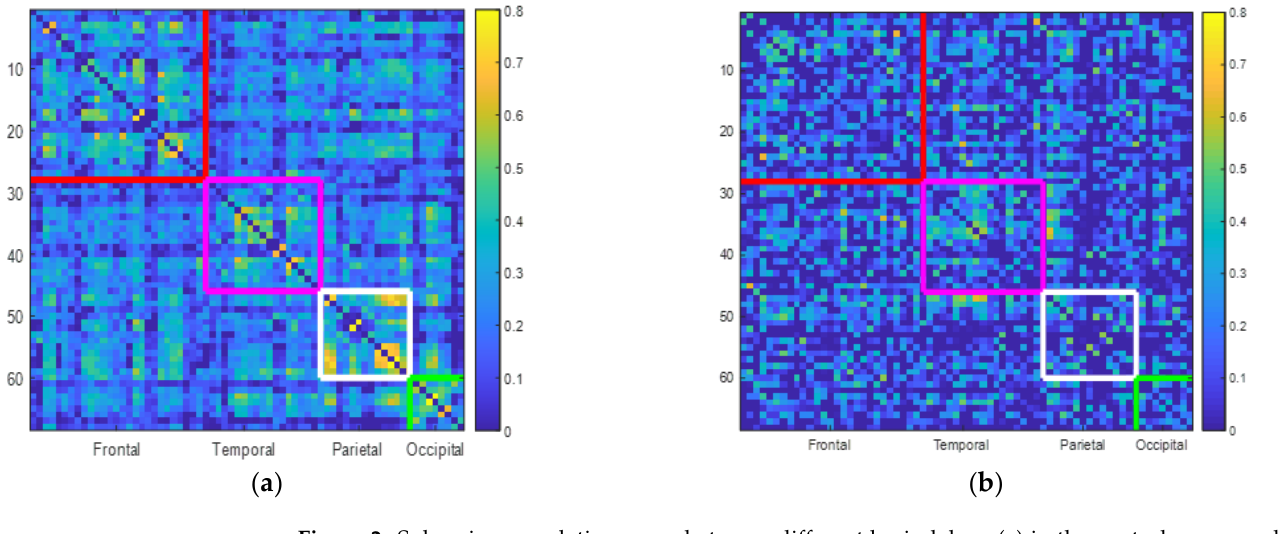
Figure 2. Subregion correlation maps between different brain lobes: ( a ) in the control group and ( b ) in the MCI group. There are 68 rows and 68 columns in each plot, and the dots from the first row and first column from the top left indicate the correlation rate of the first subregion of the ROI (left anterior cingulate) with the other 67 subregions, the second row and second column from the top left indicate the correlation rate of the second subregion of the ROI (right anterior cingulate) with the other 67 subregions, and so on. In each figure, subregions of the frontal lobe are labeled within the red line, the temporal lobe is labeled within the purple line, the parietal lobe is labeled within the white line, and the occipital lobe is labeled within the green line. The color bars indicate the density of correlation, and the color bars of the control group are scaled higher than those of the MCI group. For each brain lobe, normal control participants showed higher correlation densities within the lobes and with other lobes than the MCI group.